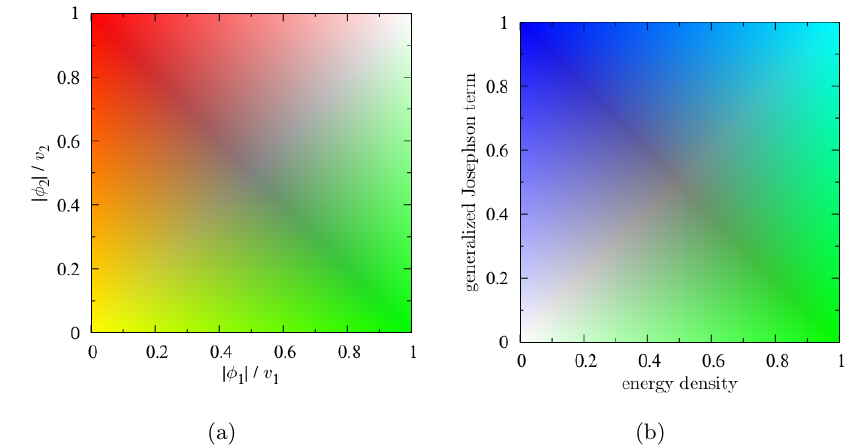
Figure 2 : (a) Visualization of 2 complex (cid:12)elds using a customized coloring scheme. The vacuum is displayed with white, the vortices of (cid:30) 1 with red, the vortices of (cid:30) 2 with green and the coincident vortices of both (cid:30) 1 and (cid:30) 2 with yellow. (b) Visualization of the energy density and the generalized Josephson term (density) using a customized coloring